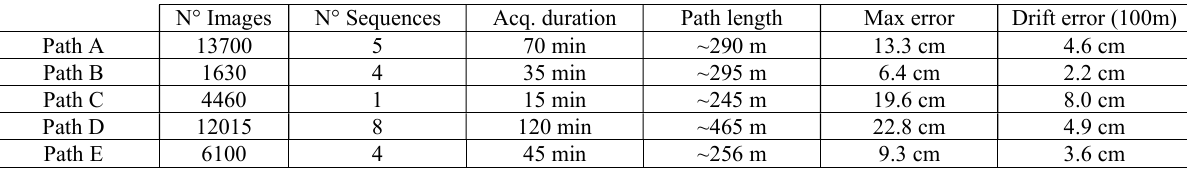
Table 4. Main Data of the five path acquisitions. Path length is computed as the distance travelled by the multicamera in the outward acquisition direction